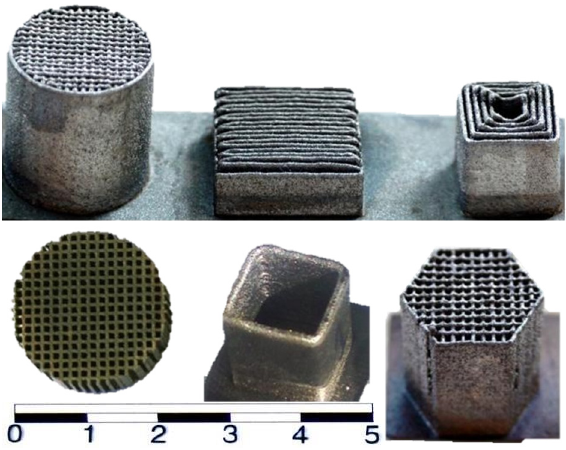
Figure 2. Examples of thin-walled components prepared by LENS